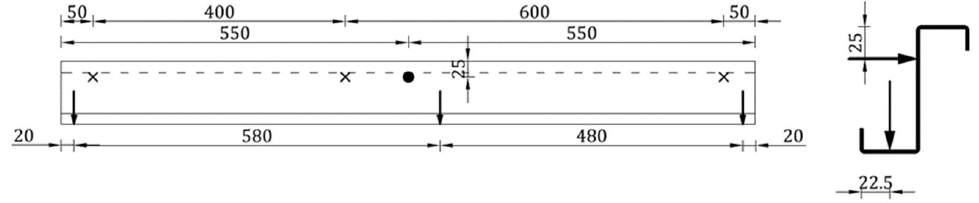
Figure 3. Position of the force and inductive displacement transducers along the thin ‐ walled beam (description in the text).